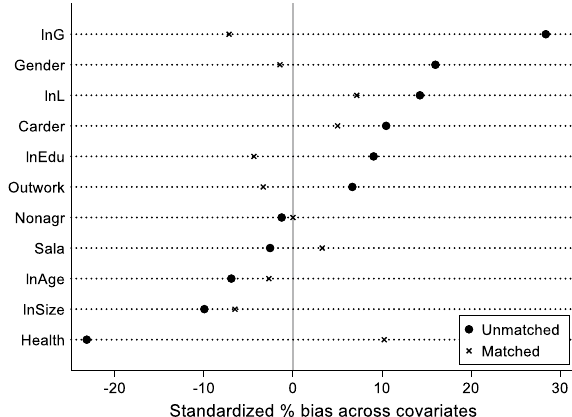
Fig. 1 Standardized percentage bias across covariates